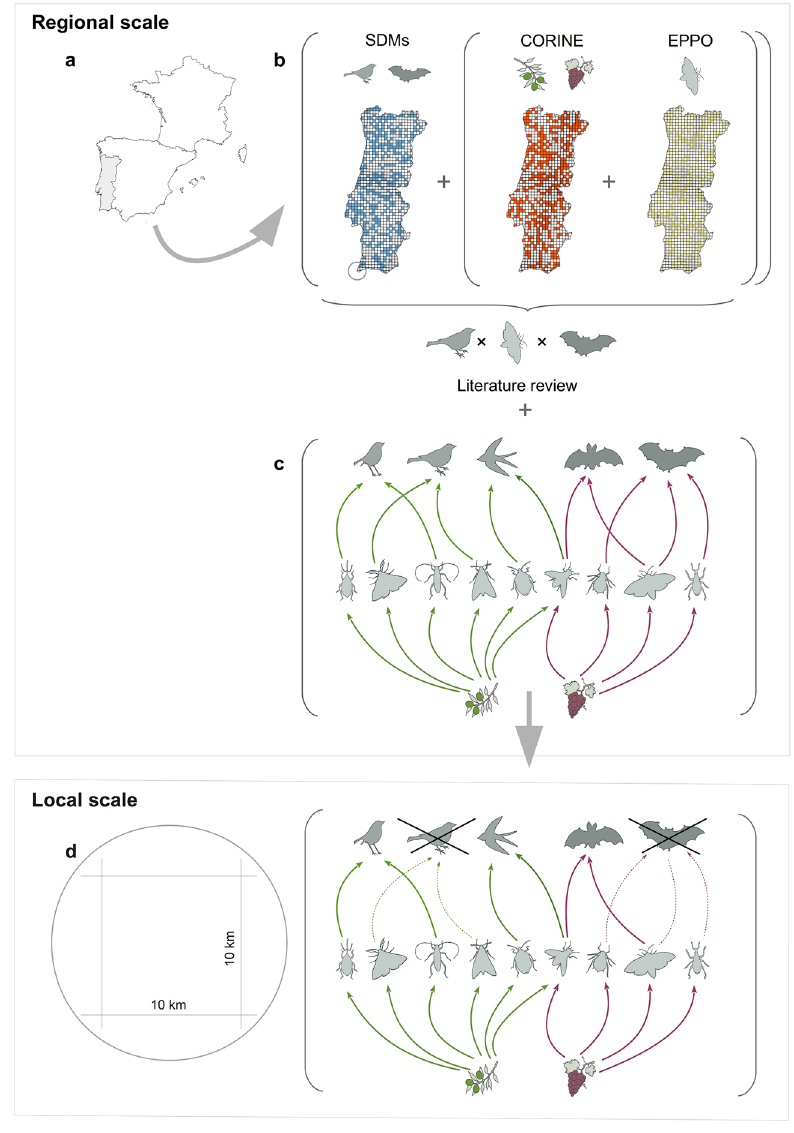
Figure 1. Study region and methodological framework. ( a ) Location of the study area, shaded area (Portugal, Western Iberian peninsula). ( b ) Species distribution models (SDMs) were used to determine the occurrence patterns (presence/absence) of vertebrate species, while data from CORINE Land Cover (CLC) and the European and Mediterranean Plant Protection Organization (EPPO) were used to determine the occurrence patterns of crops and their associated insect pests, respectively. Coloured squares represent the hypothetical distributions of the variables they represent. ( c ) Information on the consumption of pest species by predators was obtained through a comprehensive literature review. ( d ) For every 10 × 10 km grid cell in which crops were present, we calculated a crop-specific biocontrol service index ( bsi ), that represents a proxy for the relative completeness of the interaction assemblage involved in the provision of biocontrol